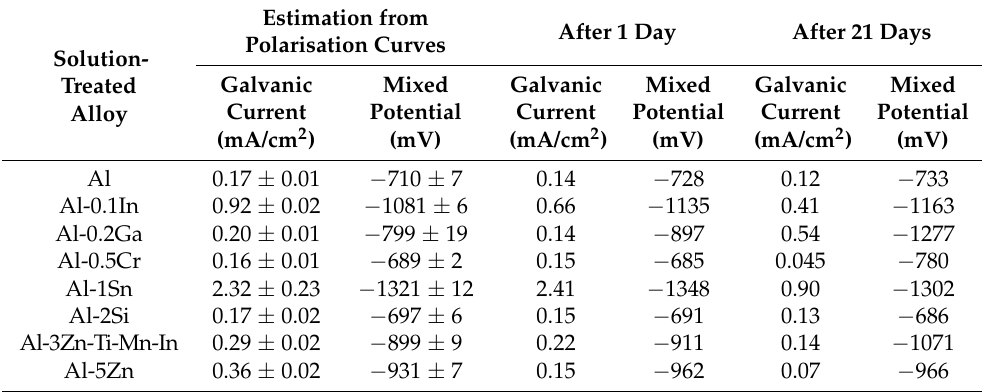
Table 5. Galvanic current and mixed potential (estimated and measured) of the solution-treated Al-based alloys vs. mild